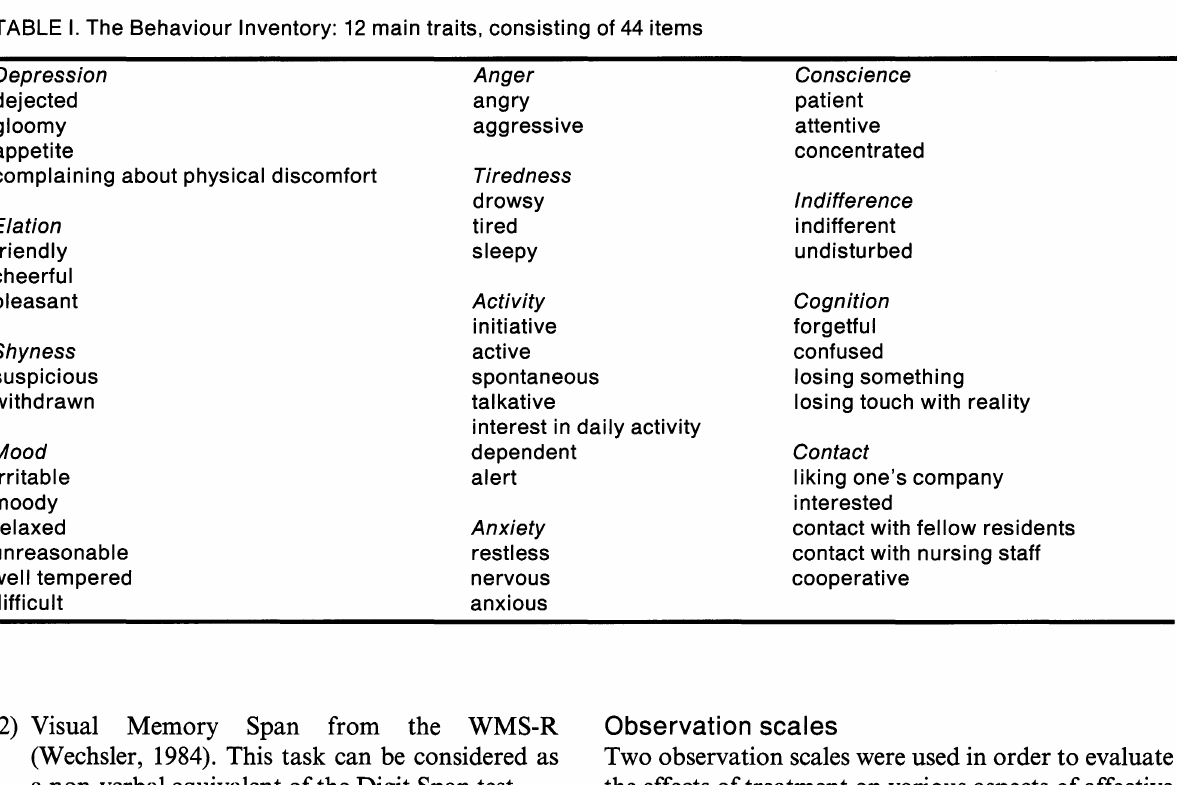
TABLE I. The Behaviour Inventory: 12 main traits, consisting of 44 items